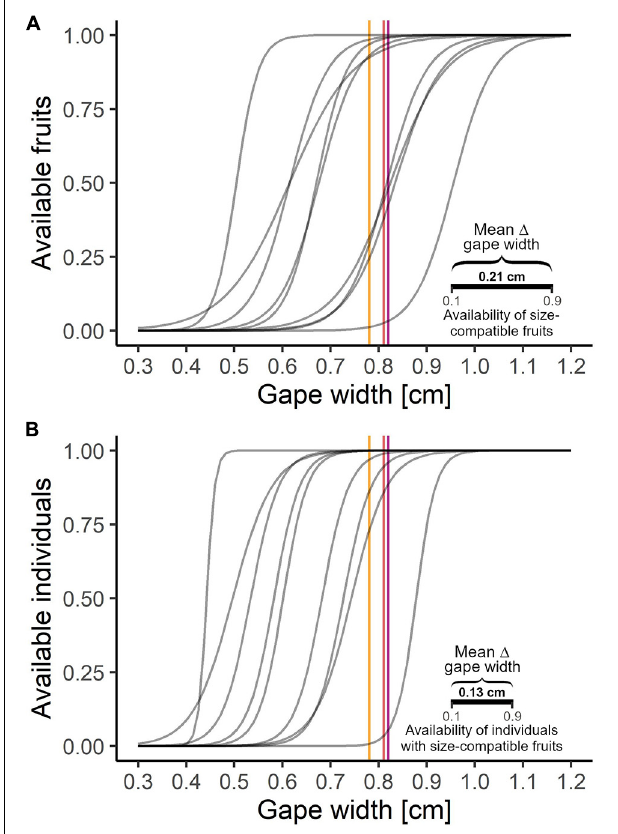
FIGURE 3 | Availability of (A) fruits or (B) individuals with size-compatible fruits as a function of the gape width of frugivorous animals. Each gray solid line displays one plant species. The black horizontal line illustrates the mean difference in the gape width of animals that allows animals to feed on either 10 or 90% of (A) fruits, or (B) plant individuals, respectively. The colored vertical lines depict the mean gape width of the small-gaped disperser E. rubecula (0.78 cm), S. atricapilla (0.82 cm) and S. borin (0.83 cm), respectively.